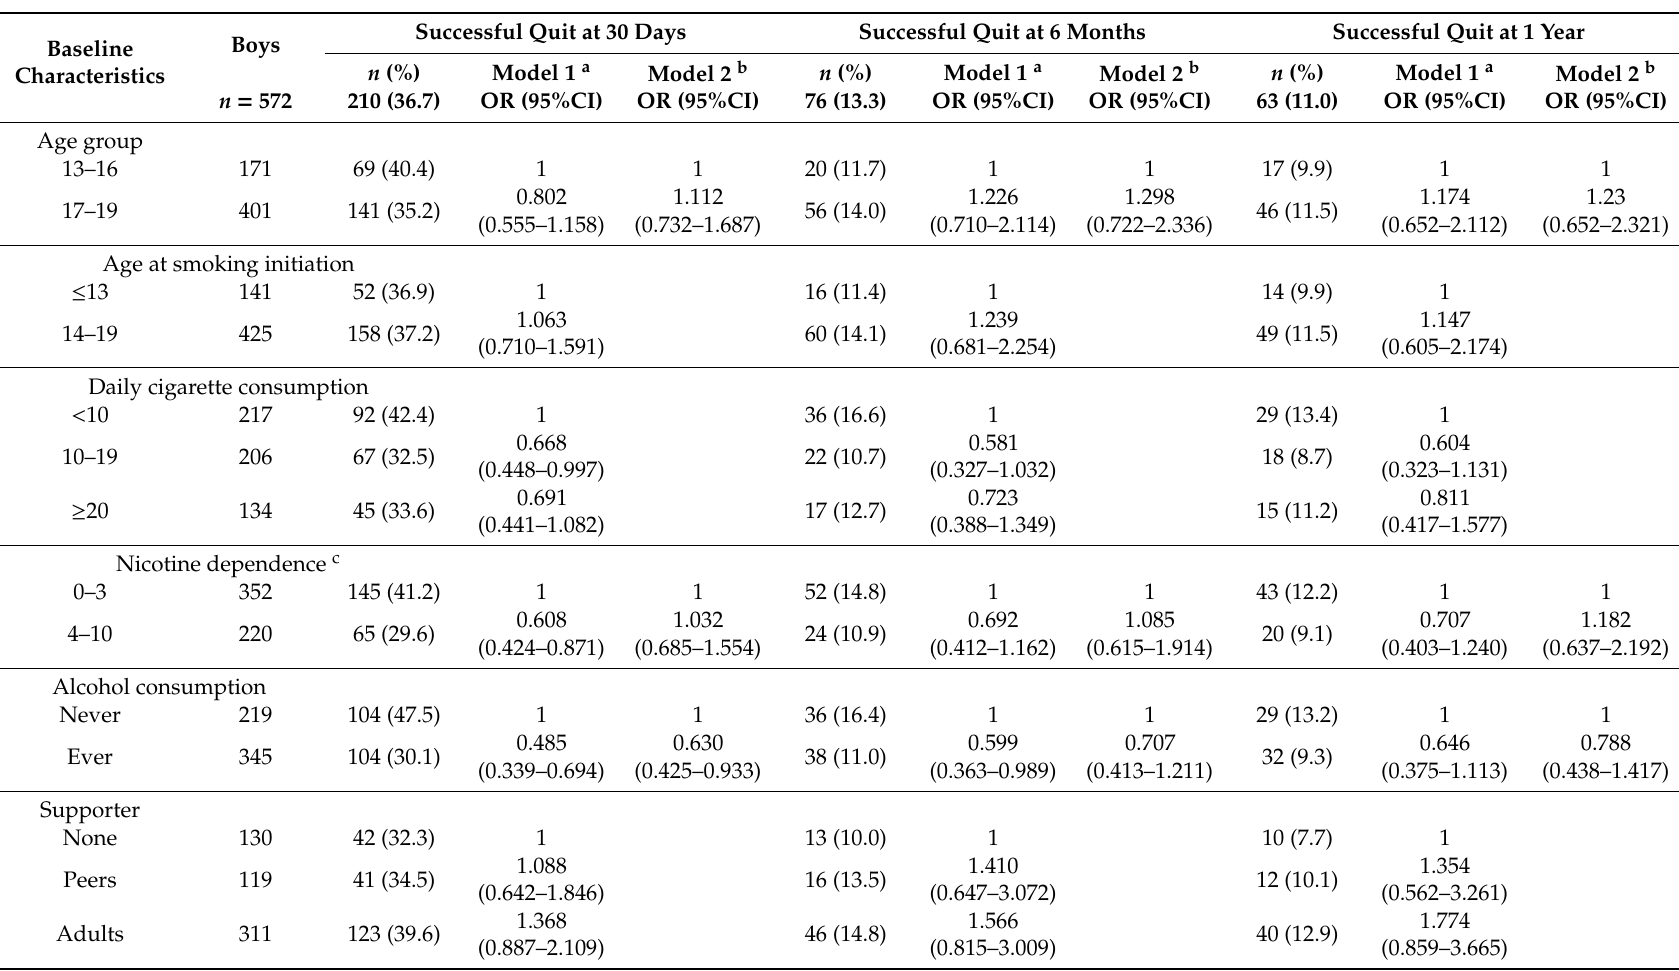
Table 3. Odds ratios and confidence intervals of potential factors associated with successful quit among adolescent Quitline users (Boys). Baseline